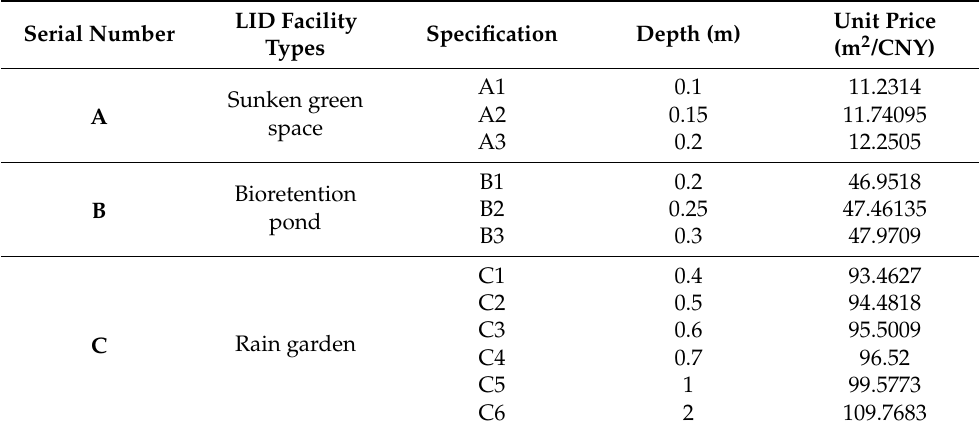
Table 2. Table of LID facility